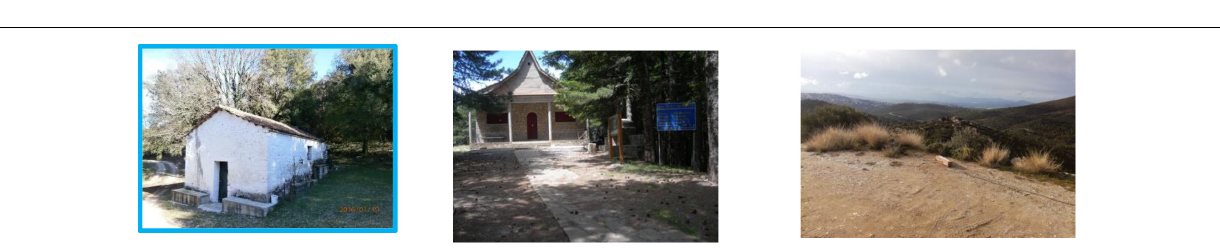
Frontiers in Earth Science |